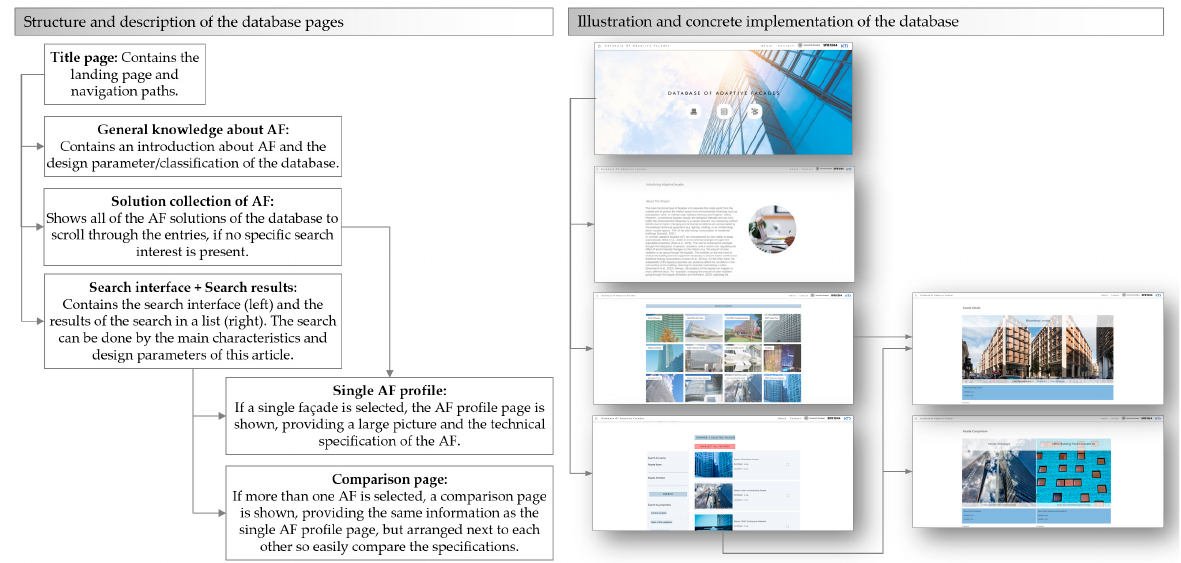
Figure 14. Structure and implementation of the user interface of the database of adaptive façades.